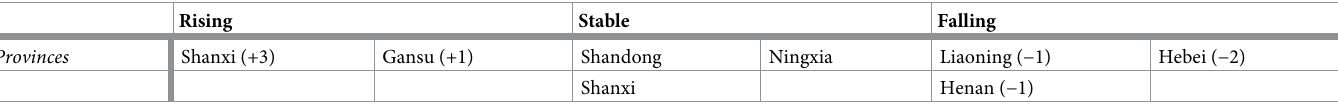
Table 3. Changes in apple industry competitiveness rankings. Rising Stable Falling Provinces Shanxi (+3) Gansu (+1) Shandong Ningxia Shanxi Henan ( − 1) Data source: China Statistical Yearbook, compilation of income data of national agricultural